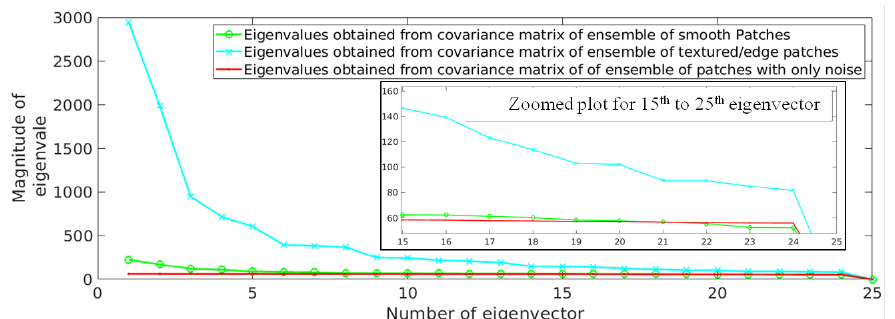
Figure 2. Demonstration of eigenvalues obtained from an ensemble of smooth patches (green) and textured/edge patches (cyan) present in a randomly selected magnetic resonance (MR) image degraded with 2% Rician distributed noise. The eigenvalues for patches with only noise are shown in red color. The x-axis denotes the number of eigenvector and the y-axis denotes the corresponding eigenvalue. The plot is zoomed for the 15th to the 25th eigenvectors and is shown to better visualize the small differences among eigenvalues. Here, 2% noise denotes that noise variance is 0.02 × 255 = 5.1 for an image with 255 as its maximum pixel